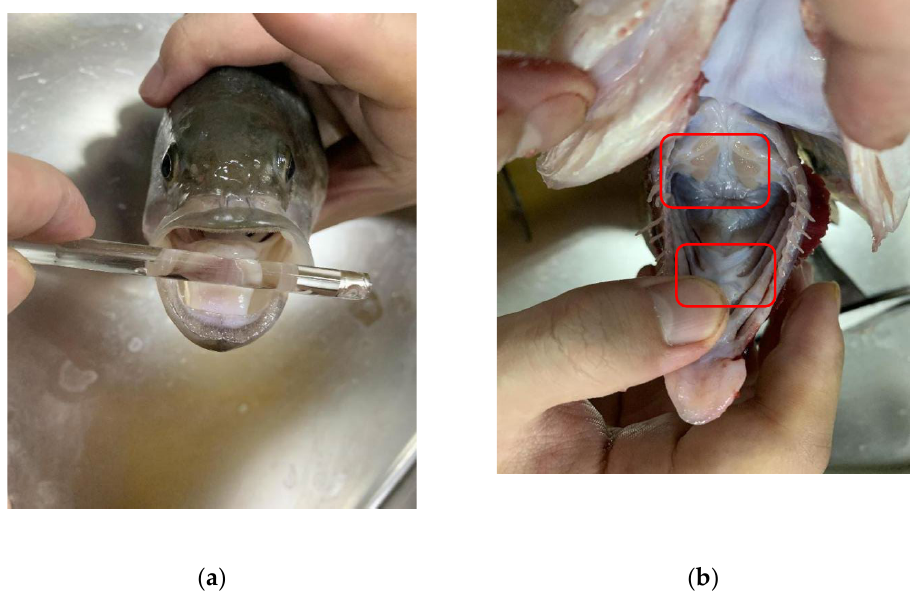
Figure 7. Swallowing vocal parts ( a ): Premaxillary tooth and chewing vocal parts ( b ): Upper red frame: pharyngobranchial teeth and bottom red frame: pharyngeal teeth.